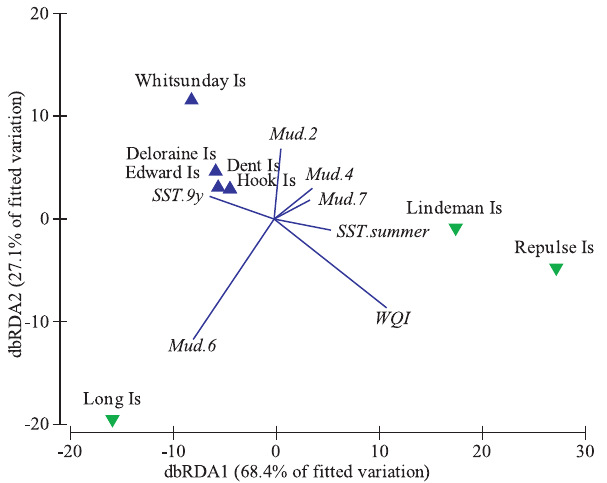
Figure 6. dbRDA ordination for the fitted model of Symbiodi- nium communities associated with the hard coral Acropora millepora and environmental parameters for two zones of water quality in the Whitsunday Islands. Symbols: . inner zone,